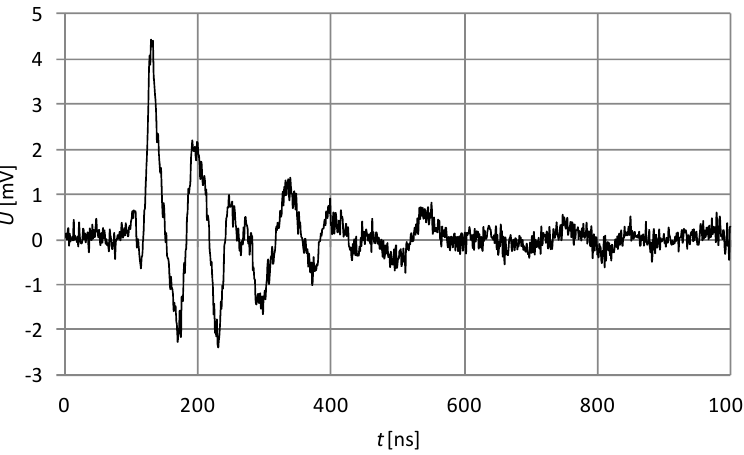
Figure 11. PD pulse recorded during insulator test.